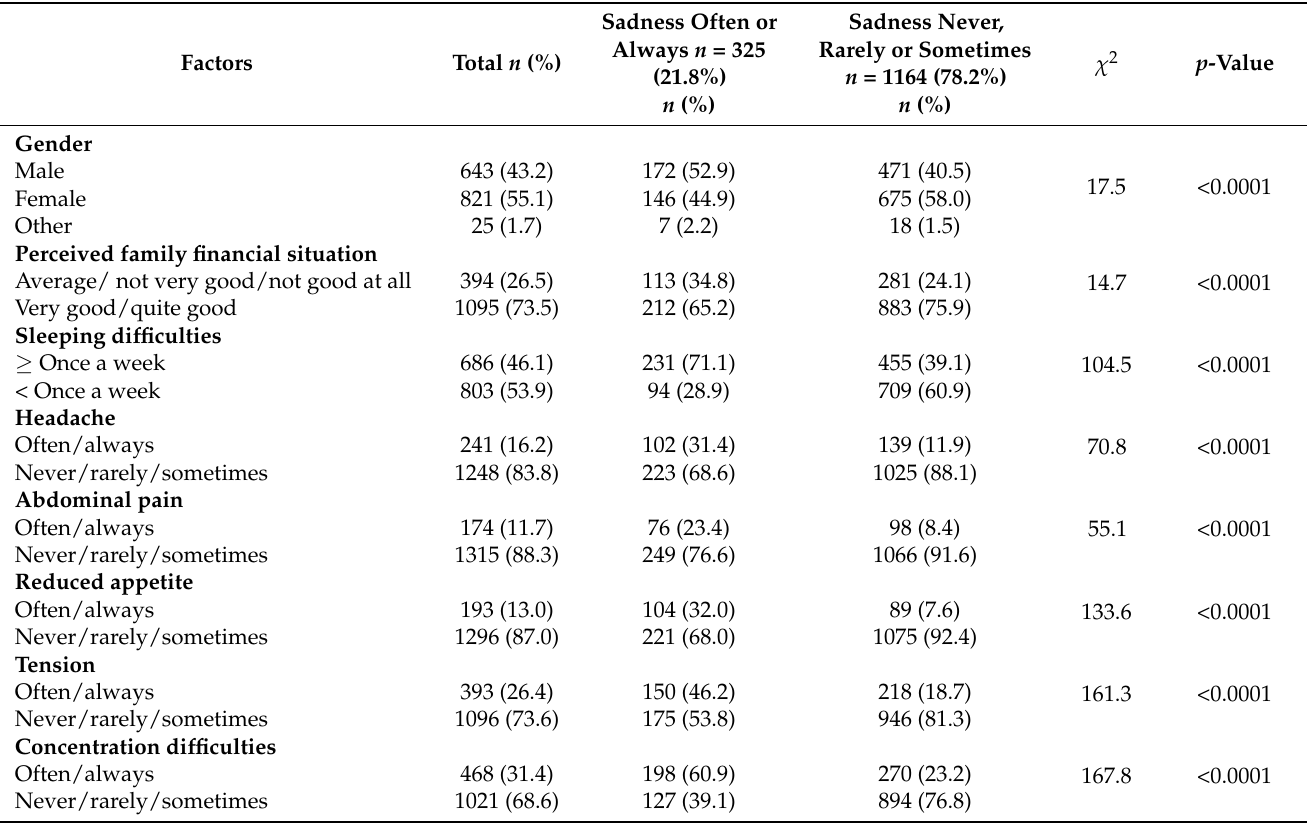
Table 1. Bivariate analysis of sadness and other factors among Swedish adolescents aged 15–17 years ( n = 1489).